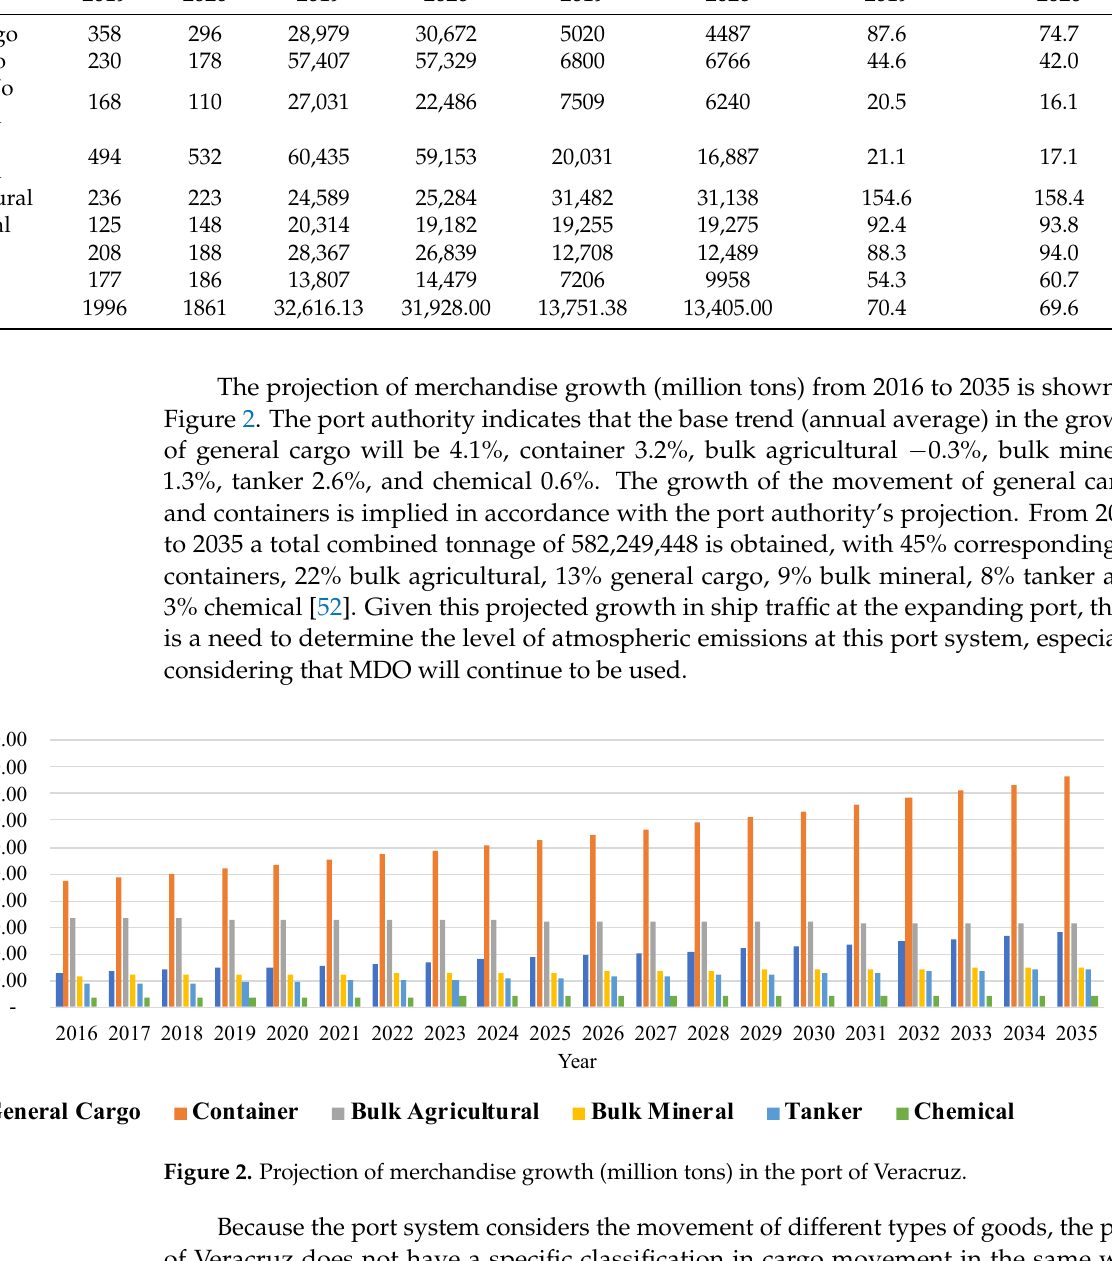
Table 1. Typology of ships in the port of Veracruz [53].